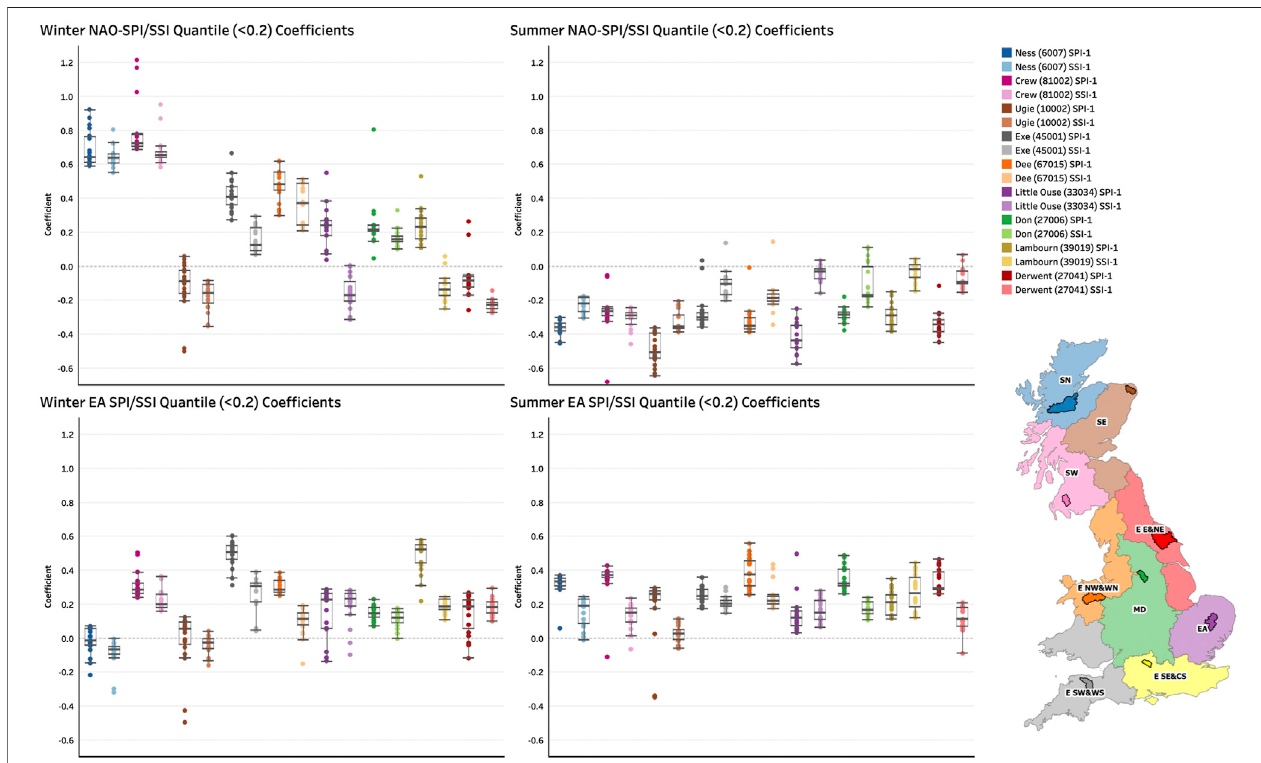
FIGURE7| Extractedquantilecoef fi cients betweentheNAO/EAindicesand SPI-1/SSI-1 values.Coef fi cientswereextracted forquantiles < 0.2,therangeofthese quantile coef fi cients is represented in this fi gure as box plots.